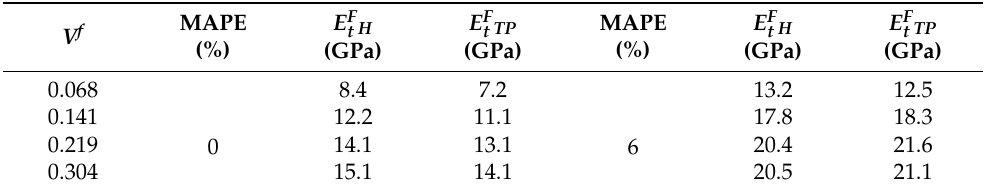
Table 2. Intrinsic Young’s modulus of corn stover fibers (CSF) for coupled an uncoupled composites obtained using micromechanics models.